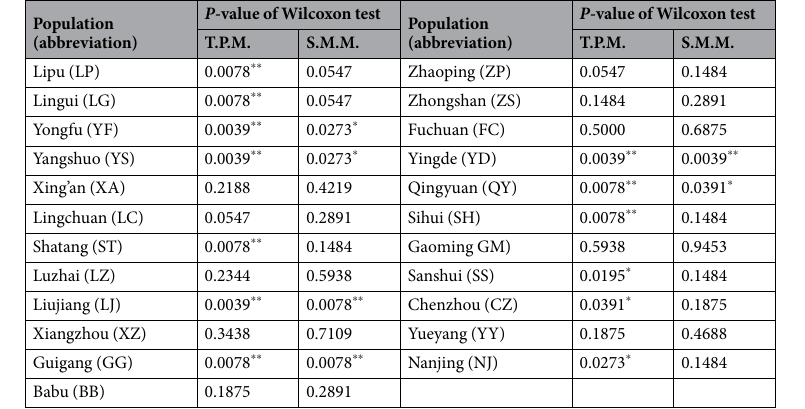
Table 2. P -value for Wilcoxon’s test for heterozygosity excess conducted in Bottleneck for twenty-three P. clarkii populations. TPM: two-phased model of mutation, SMM: stepwise mutation model, * P < 0.05, ** P < 0.01.